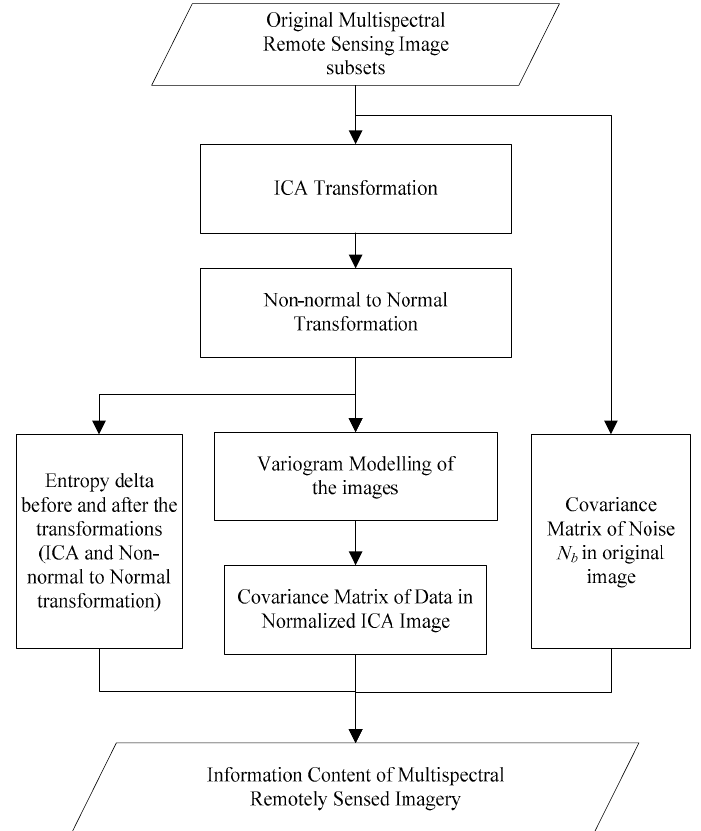
Figure 1. The flowchart describing the methods for quantifying information content in multispectral images.